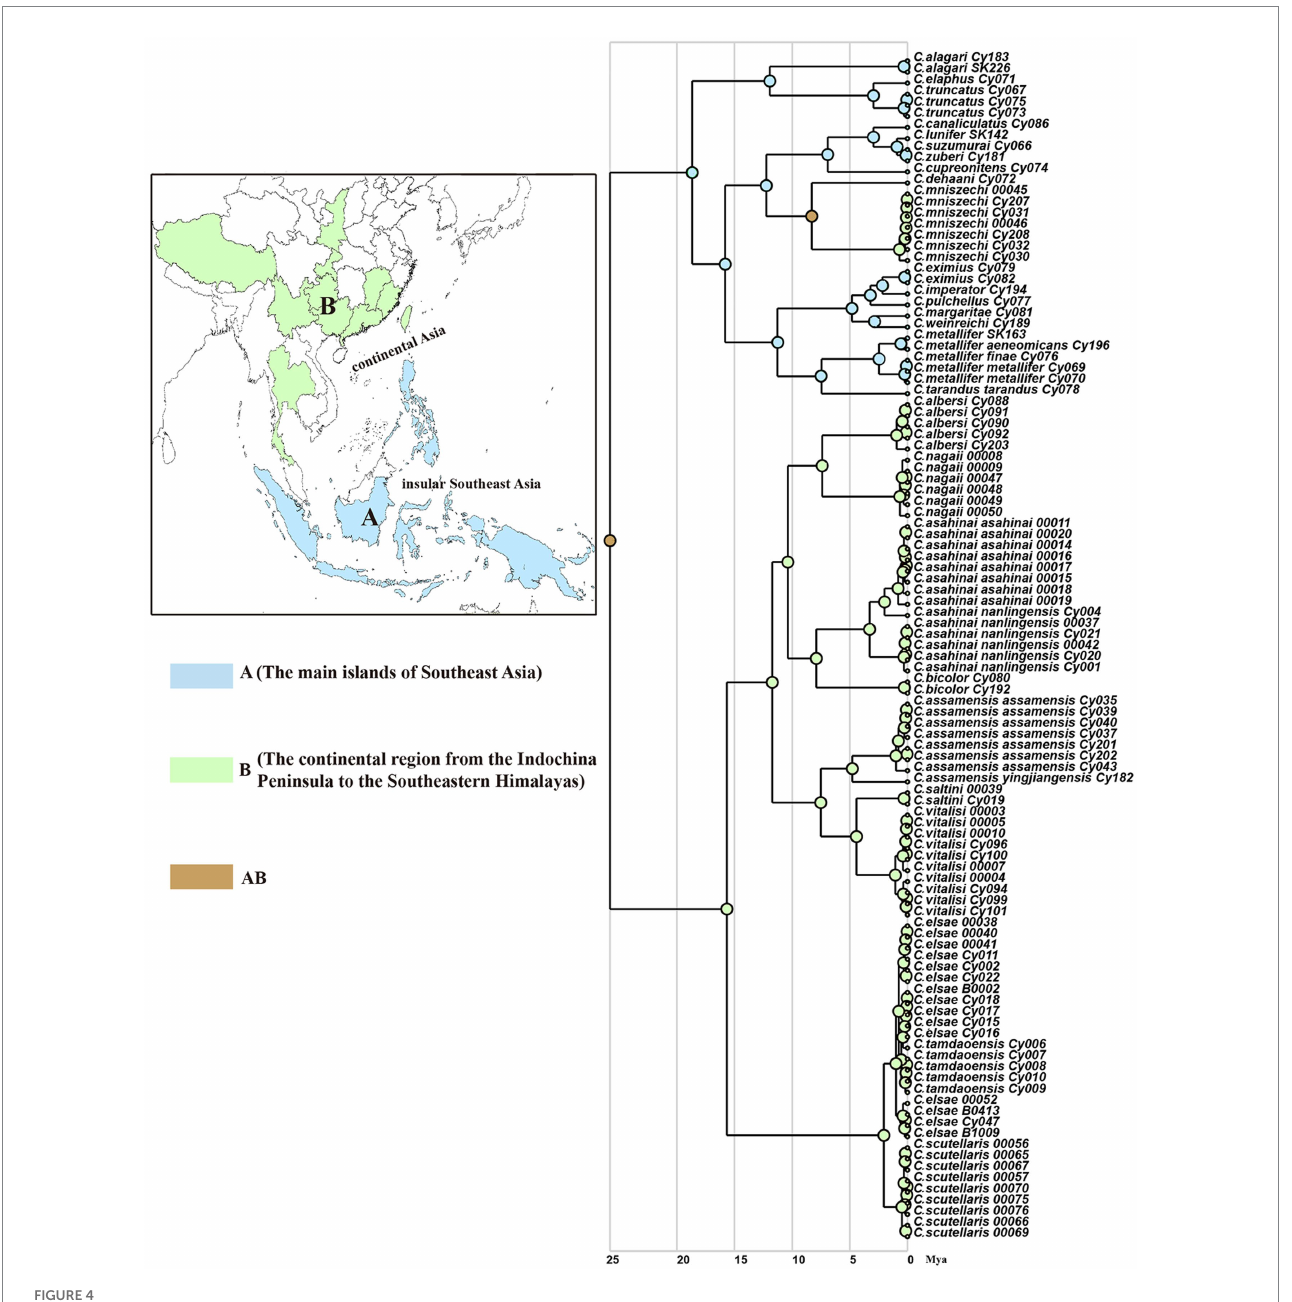
FIGURE 4 Spatiotemporal reconstruction of Cyclommatus stag beetles based on the best-fitting model (DIVALIKE) inferred using RASP and the maximum clade credibility tree from BEAST analyses. Color circles reflect biogeographic designations (for species at tips), and different colors within the pie charts at the nodes represent the probabilities of different geographical areas. A, the main islands of Southeast Asia; B, the continental region from Indochina Peninsula to the Southeast Himalaya